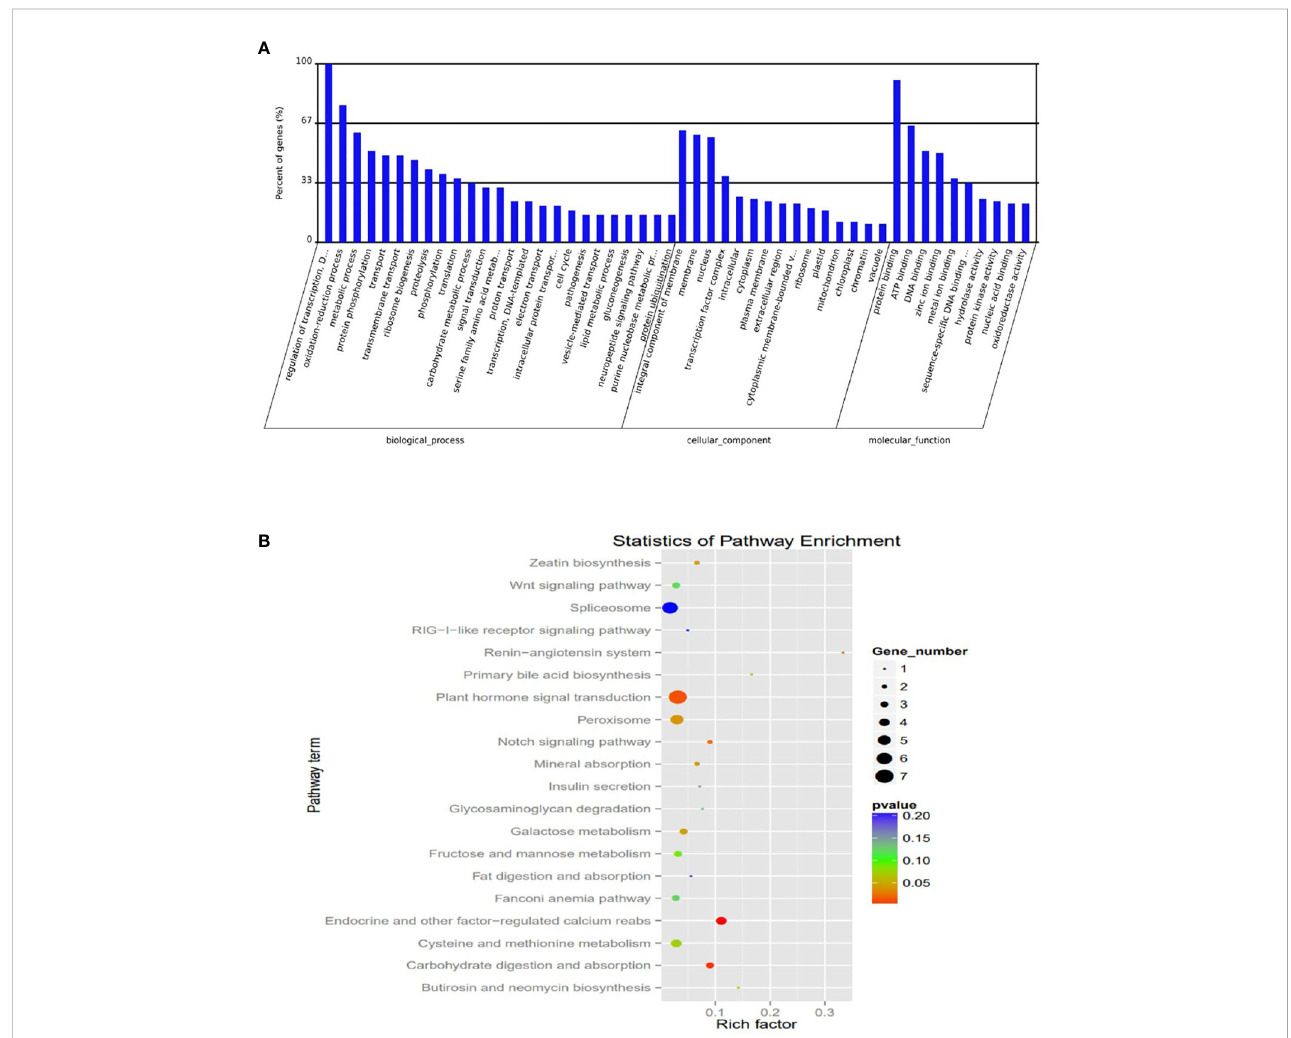
FIGURE 6 Plots of Characterization was based on (A) Gene ontology (GO) categories in the root apex of four bermudagrass libraries (B) Kyoto Encyclopedia of Genes and Genomes (KEGG) pathway